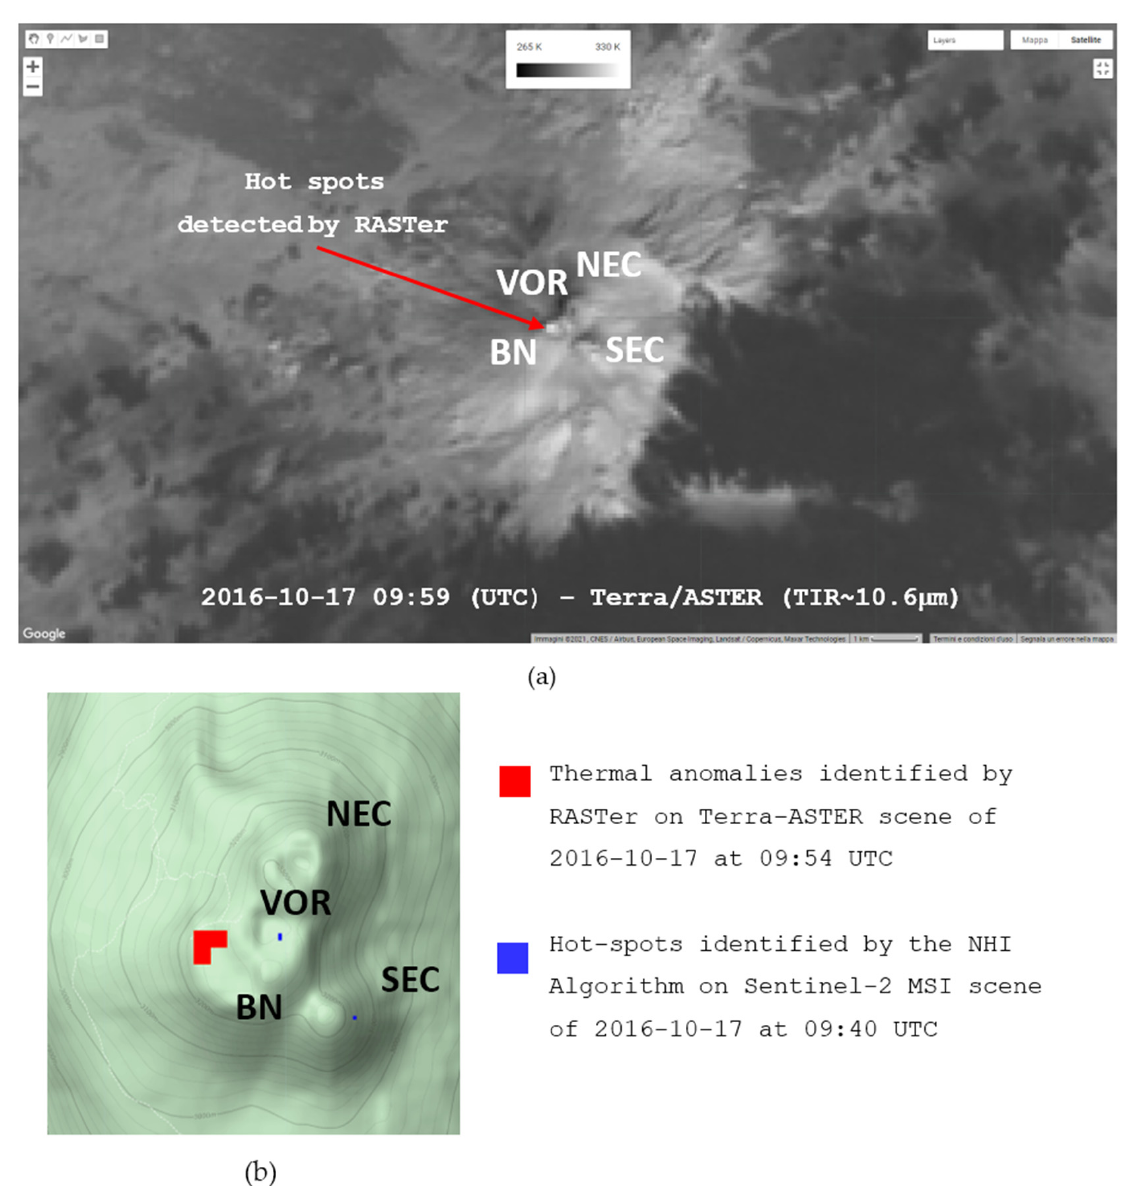
Figure 10. ( a ) ASTER TIR image 17 October 2016 at 09:54 UTC covering Mt. Etna area; ( b ) thermal anomalies detected by RASTer (red pixels) and NHI SWIR ([20]) on Sentinel-2/MSI data of 09:40 UTC (blue pixels) overlapped to the topographic map of Mt.